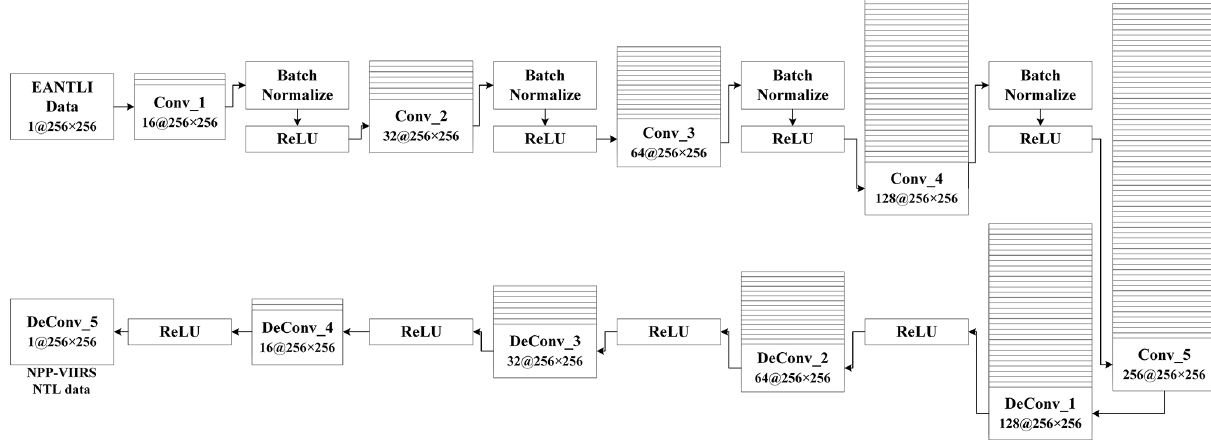
Figure 4. The overall architecture of our proposed auto-encoder with